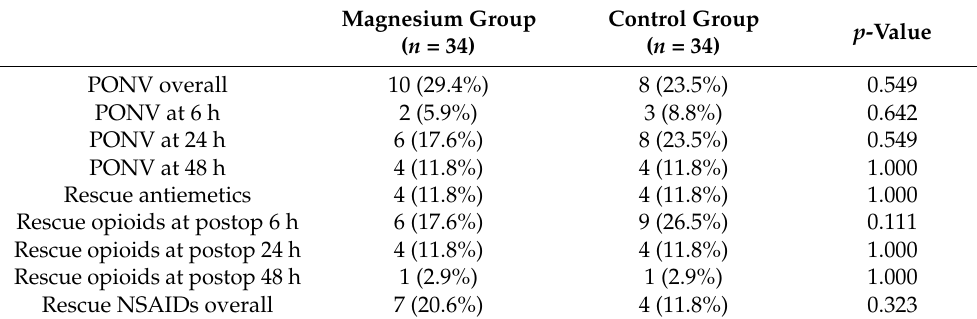
Table 5. Incidence of postoperative nausea and vomiting, rescue antiemetics, and analgesics during the first 48 h after